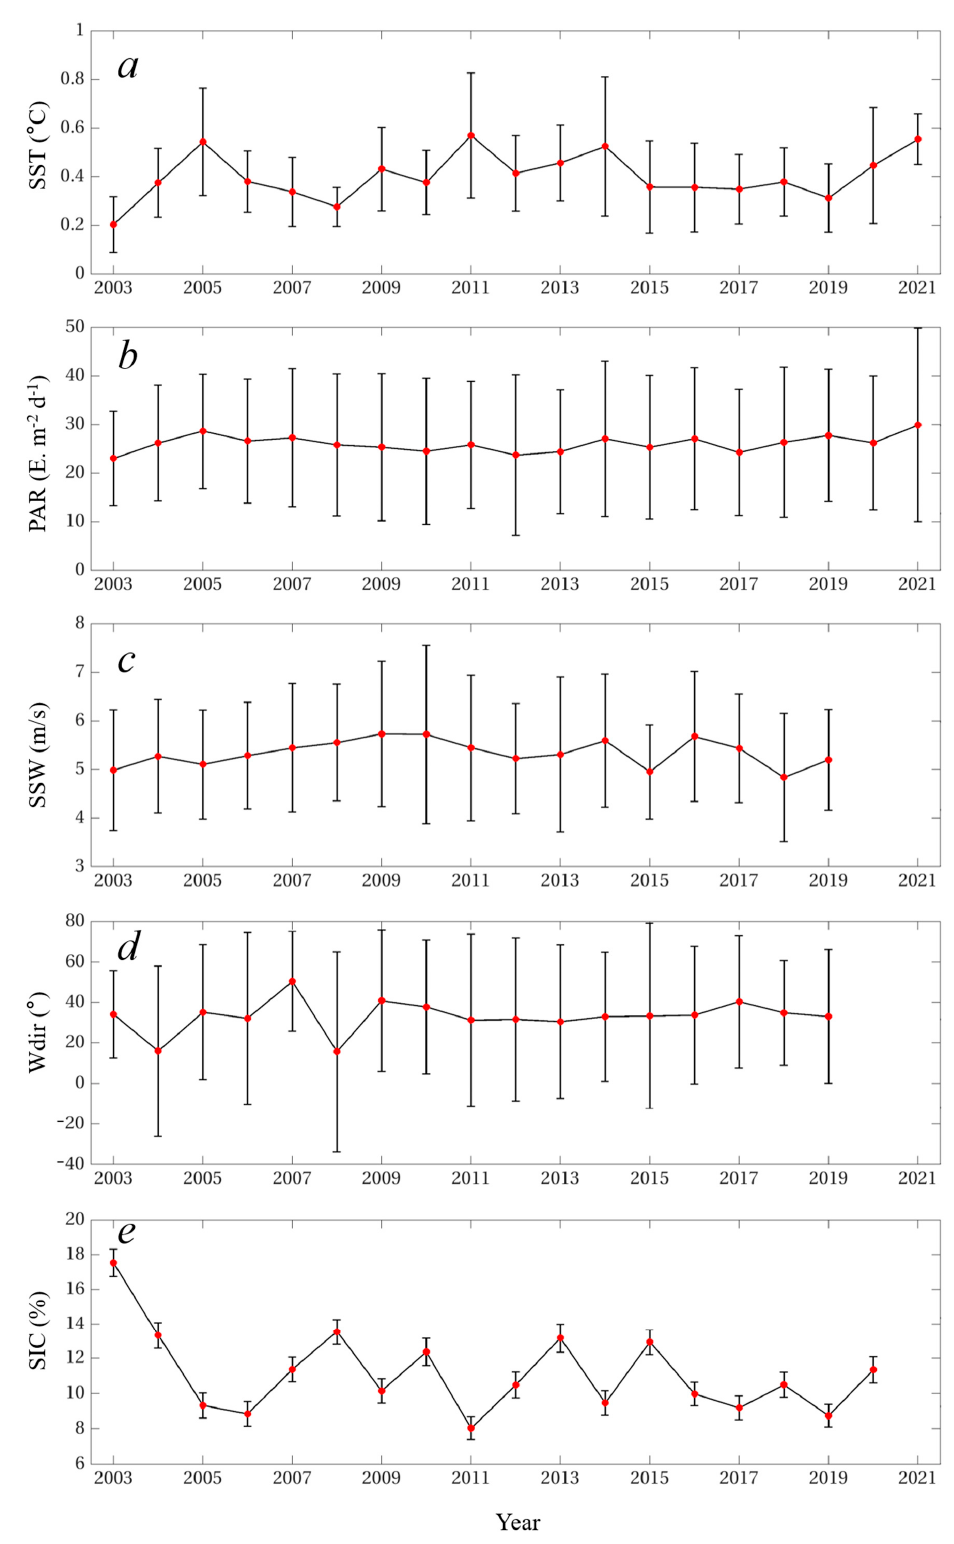
Figure 5. Interannual variations of SST ( a ), PAR ( b ), SSW ( c ), Wdir ( d ), and SIC ( e ) between 2002 and 2021 in the Ross